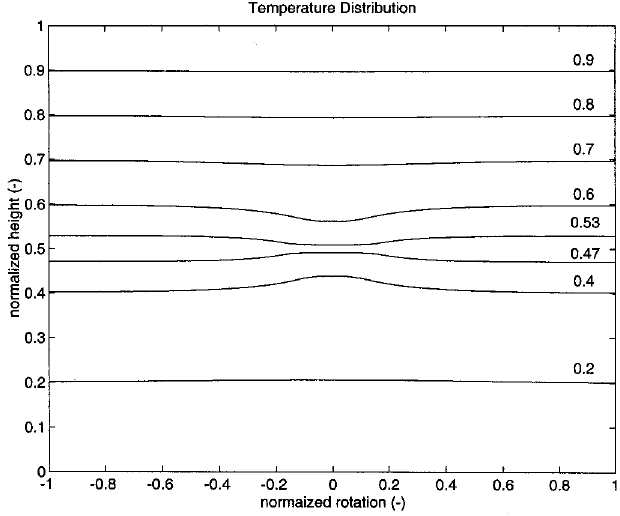
Figure 5. Computational result of normalized temperature distribution.